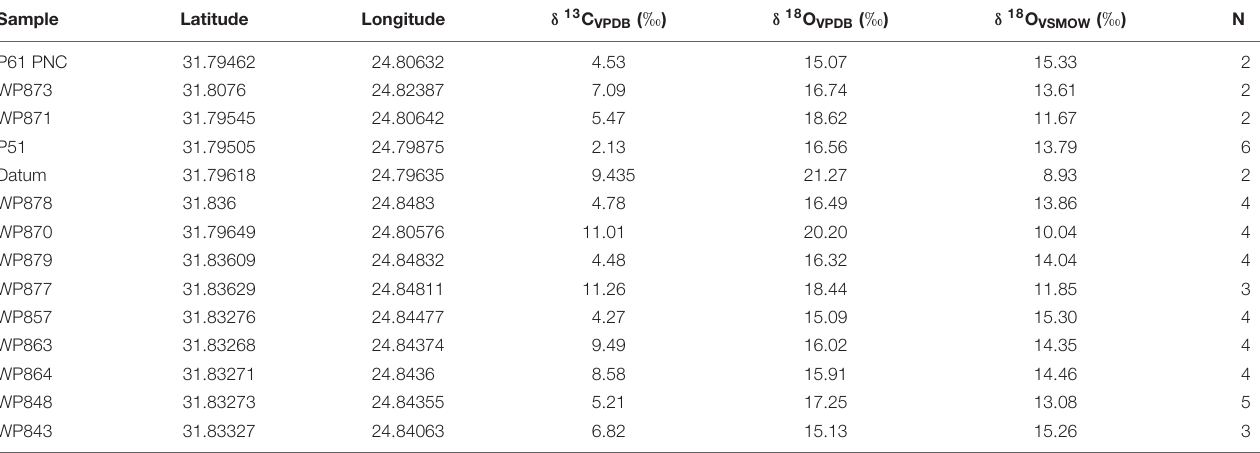
TABLE 1 | Mean δ 13 C VPDB and δ 18 O values of pedogenic nodule-calcite cements obtained from intraformational conglomerate deposits, with GPS coordinates, and stratigraphic positions across the area from Old Lootsberg Pass to Tweefontein 2 ( Figure 4 ). Sample